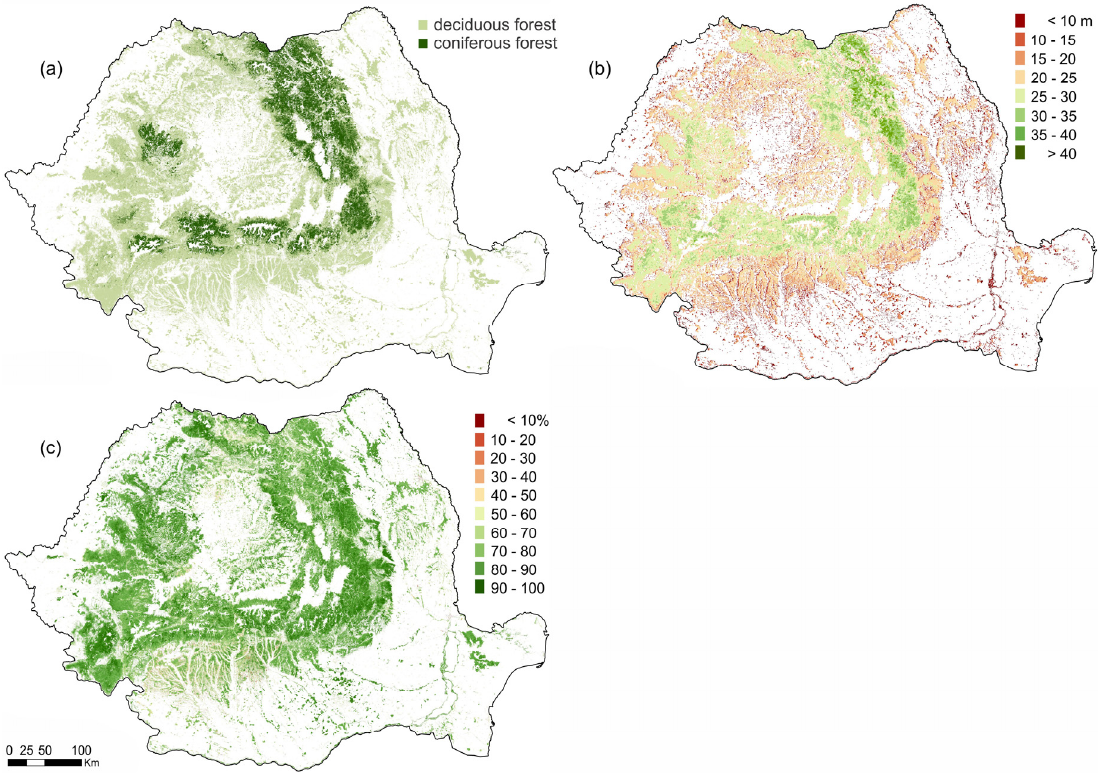
Figure 3. The spatial data used to estimate AGFB in 2015: forest vegetation cover and the dominant forest types ( a ), forest height ( b ) and forest canopy density ( c ).